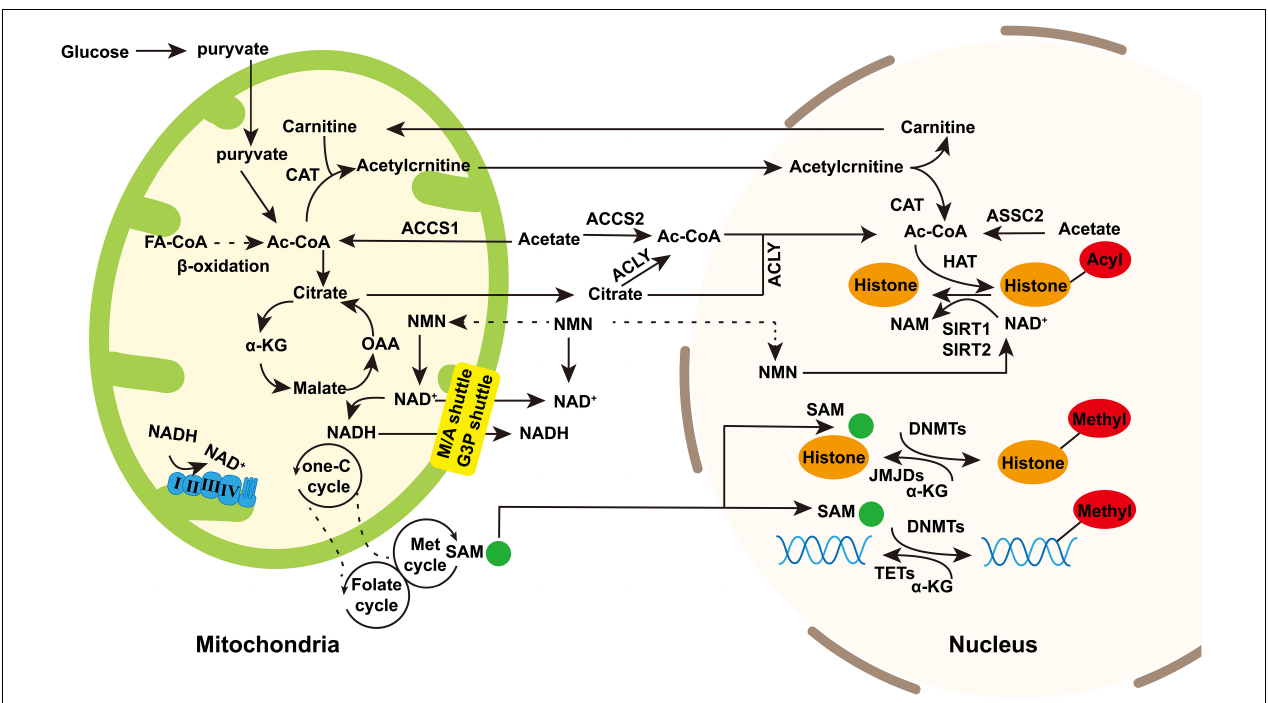
FIGURE 1 | The regulation of mitochondrial intermediate metabolites to nuclear epigenetics. Mitochondria provide substrates for nuclear epigenetics such as DNA or histone methylation and histone acetylation/deacetylation. Acetyl-CoA is the source of acetyl groups used in histone acetylation. It is produced during fatty acid synthesis and glycolysis. Besides, acetate is catalyzed by ASSC1 in mitochondria and ASSC2 in cytoplasm and nucleus to generate acetyl-CoA. Acetyl-CoA in the nucleus and cytoplasm can be exchanged through nuclear pores. Acetyl-CoA enters into TCA cycle to produce citrate in mitochondria which is transported into cytoplasm and then catalyzed by ACLY to regenerate acetyl-CoA. Acetyl-CoA produced in mitochondria can also be regenerated in nucleus trough carnitine/acylcarnitine translocator. NAD + is the cofactor of sirtuins in deacetylation. In TCA cycle, NAD + is converted into NADH, and then NADH reconverted into NAD + by complex I and III in OXPHOS. NAD + /NADH in mitochondria can be exchanged in cytoplasm and mitochondria through malate/aspartic acid shuttle and glyceraldehyde-3-phosphate shuttle. NAM is potentially transported into mitochondria and nucleus to generate NAD + . S -adenosine methionine (SAM) is generated through the coupling of the folate and methionine cycles in the cytosol and sustained by the one-carbon (one-C) metabolism in mitochondria. SAM can enter into nucleus as the source of methyl group in histone or DNA methylation. α -Ketoglutarate ( α -KG), the intermediate of TCA cycle, can enter into nucleus as the cofactor of JMJDs and histone demethylases and TET DNA demethylases. Dashed arrows indicate potentially indirect connections or pathways that need further validation. Abbreviations: FA-CoA, fatty acyl CoA; ac-CoA, acetyl-CoA; CAT, carnitine acetyltransferase; OAA, oxaloacetic acid; ACLY, ATP-citrate lyase; NMN, nicotinamide mononucleotide; M/A shuttle, malate/aspartate shuttle; and G3P shuttle, glyceraldehyde 3-phosphate